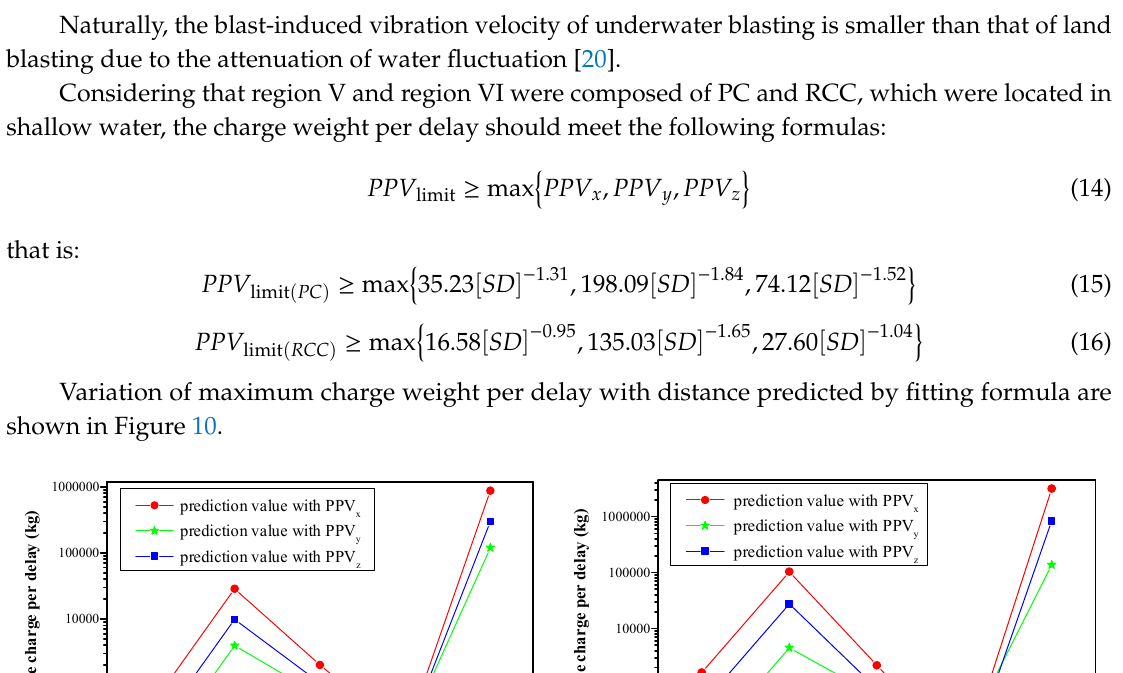
Figure 9. The explosive unit consumption in land blasting and underwater blasting.